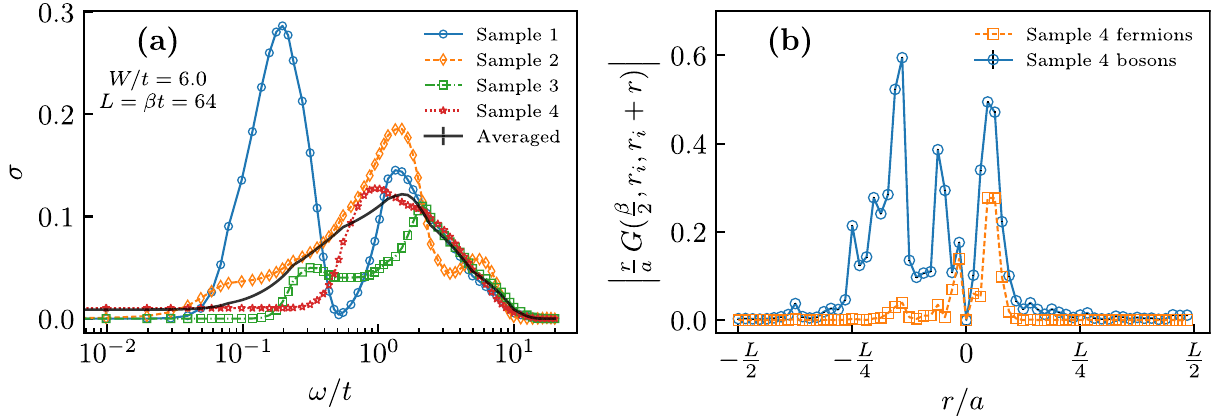
Fig. 4 Overview of individual disorder realizations. a Optical conductivity as a function of frequency for different disorder realizations (the black continuous line is the average over all 384 disordered samples). b Correlation function j r G τ ¼ β ð r ; r Þ maximum. Data were reported for both the bosonic system (blue circles) and the corresponding system of free fermions (orange squares). of the G β i i 2 This plot visualizes dominant contributions to the current for a single disorder realization when the particle starts from point r i (see main text and Methods). In both panels, data were shown for L = β = 64 and W = 6. Vertical error bars in b indicate the estimated uncertainty extracted from the Monte Carlo simulations.